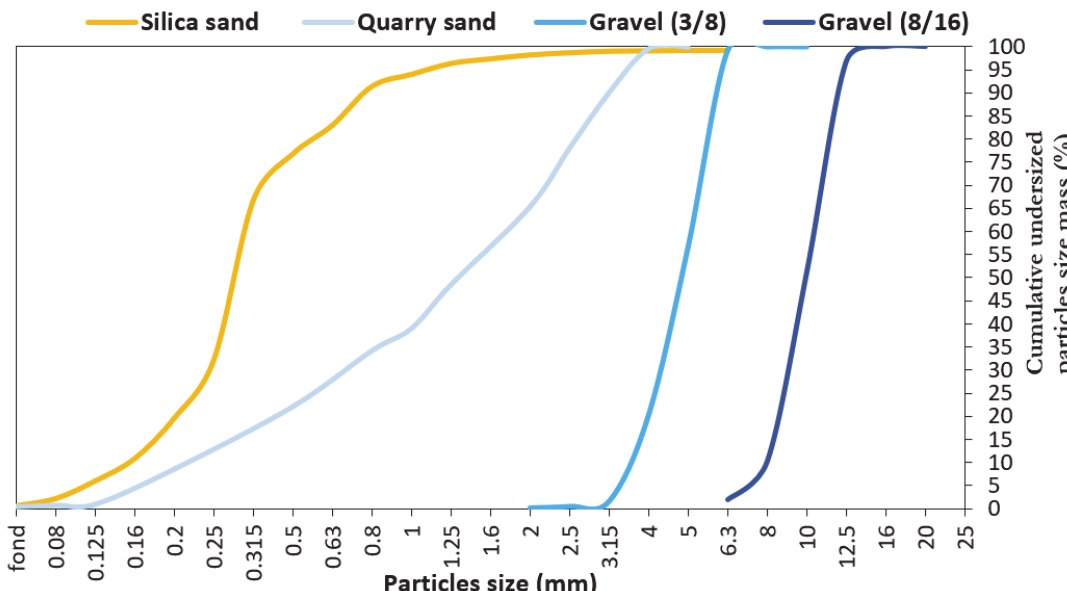
Figure 1: Granulometric curves of the aggregates used (NF P 18-560) [52].